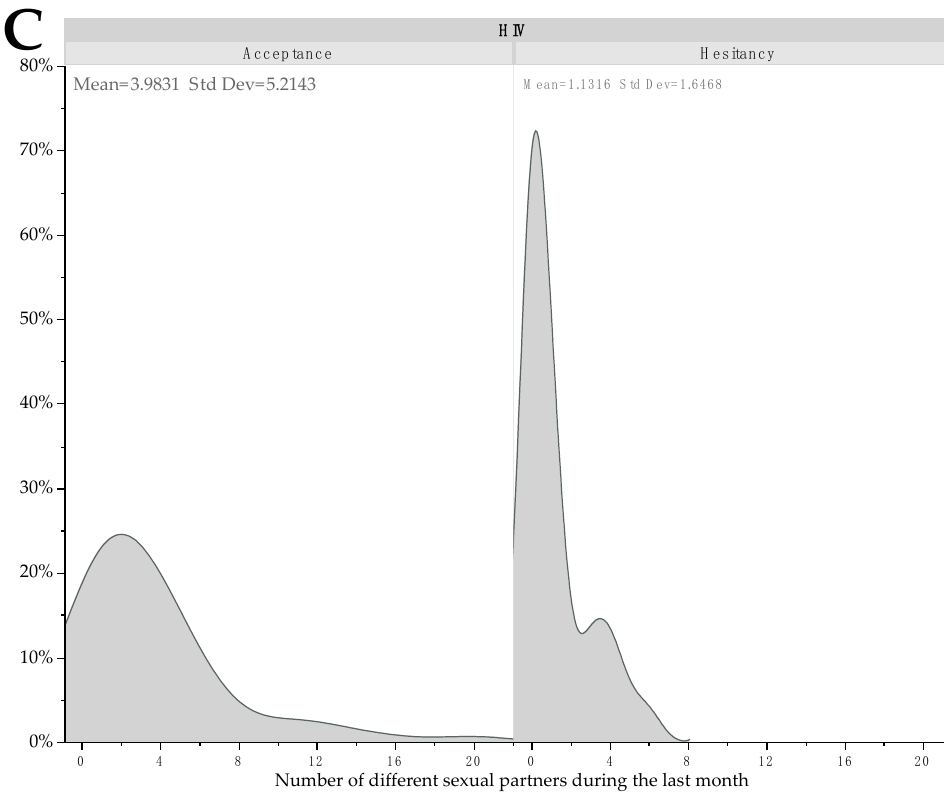
Figure 1. Kernel density plots for number of different sexual partners the last month according to HIV and PrEP status ( A ), and hesitancy or not in PrEP patients ( B ) and in HIV patients ( C ).